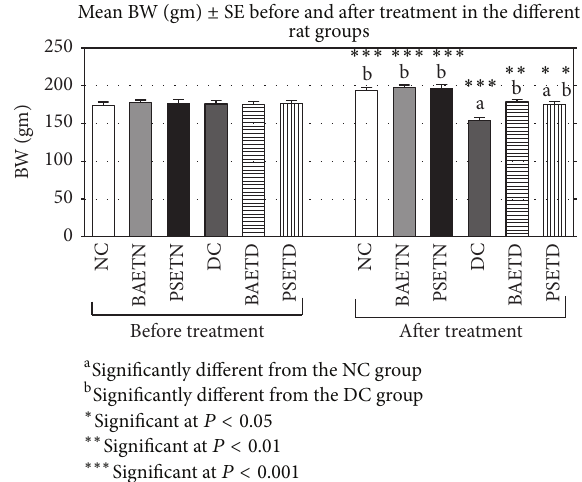
Figure 1: The effect of Balanites aegyptiaca fruits and Petroselinum sativum leafaqueousextractsonmeanBW(gm)innormalandSTZ- induced diabetic rats (mean ± SE).